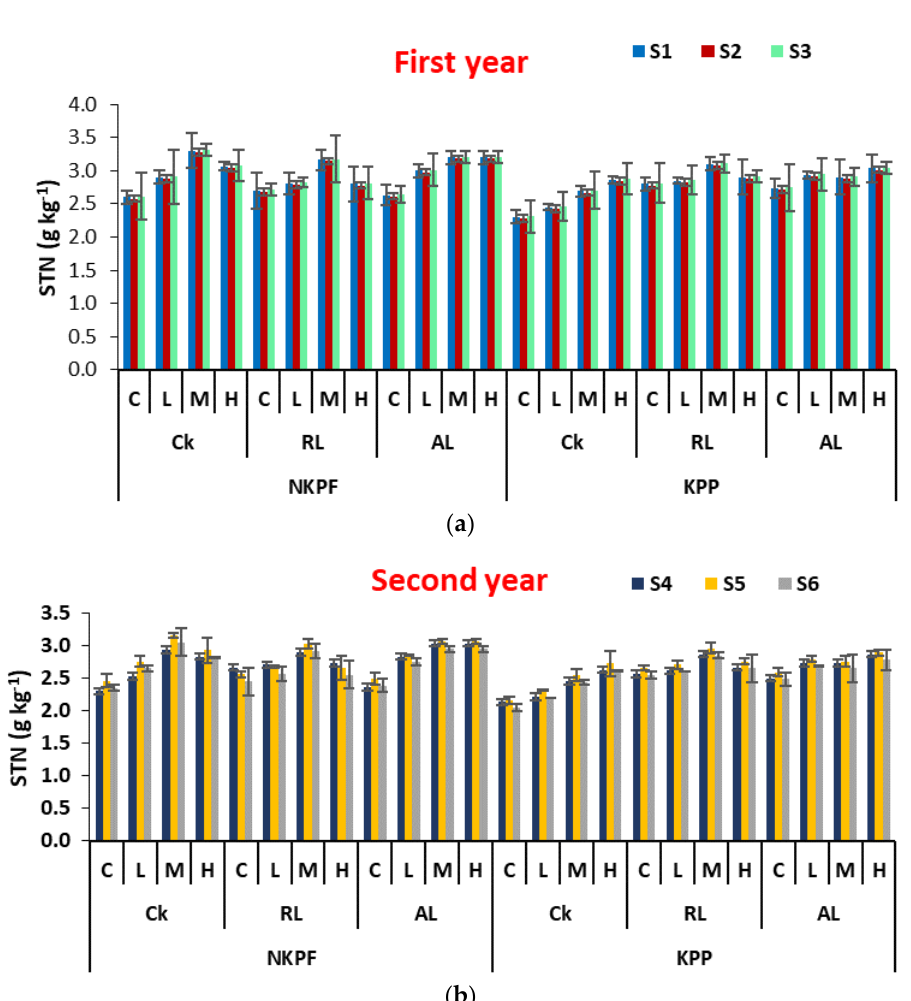
Figure 1. Changes in STN during ( a ) first year and ( b ) second year of experiment affected by different litter treatments at various N and P levels under two forest types.